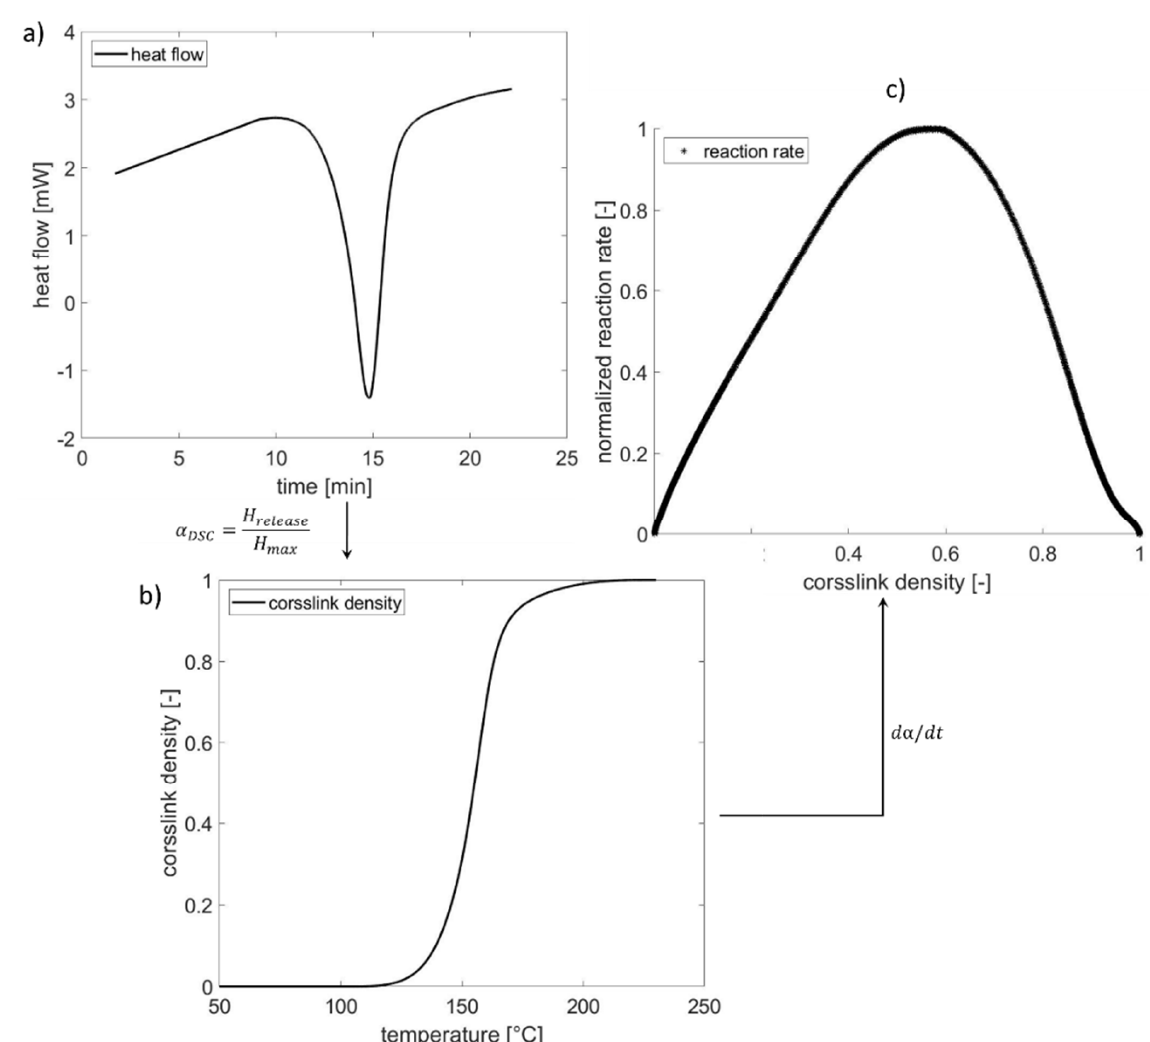
Figure 2. Evaluation procedure of DSC result measured under the non-isothermal condition: ( a ) change of heat flow during the curing process with heating rate 10 °C/min, ( b ) crosslink density, and ( c ) reaction rate in dependency of curing amount.